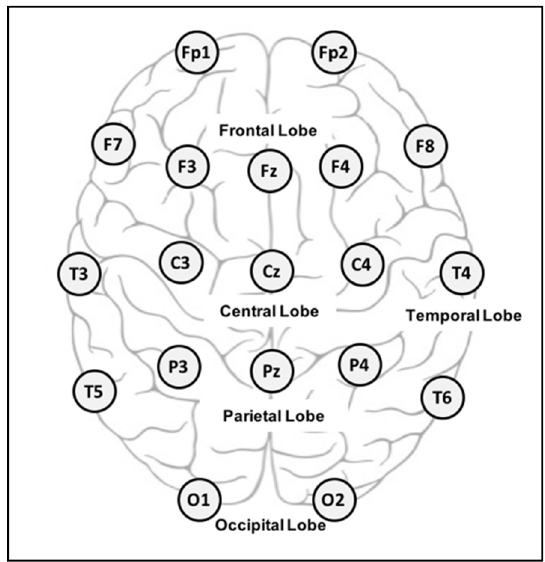
Figure 2. 10–20 system of electrode placement.